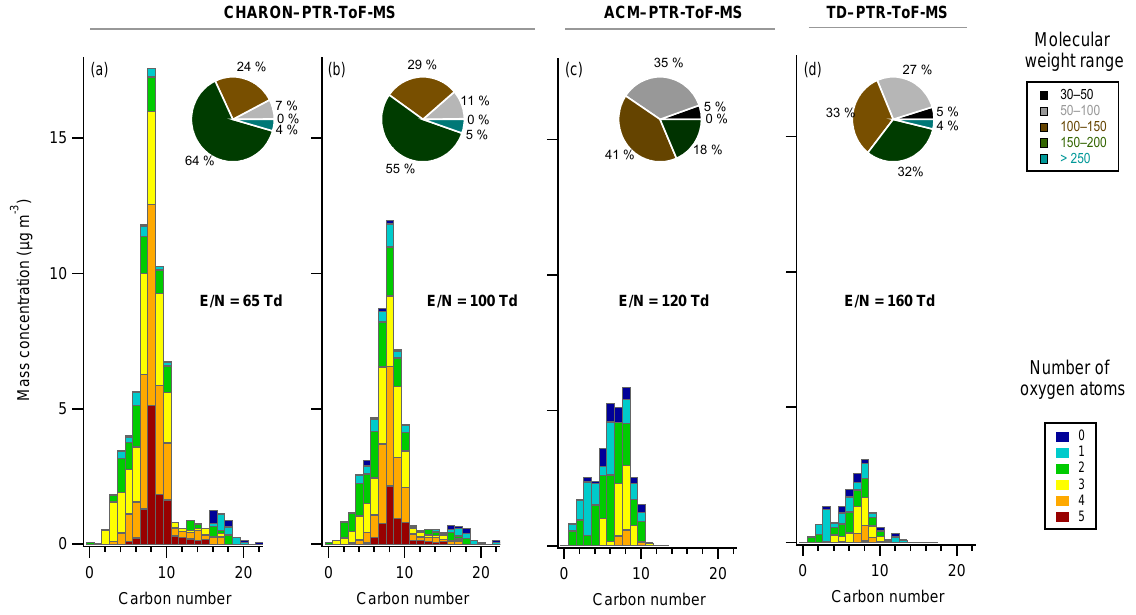
Figure 3. OA mass concentration ( y axis) distributed based on the number of carbon atoms ( x axis). Bar colours correspond to the contribu- tion of oxygen atoms starting from 0 (blue) to 5 (red) for each carbon group when (a) CHARON was operated at E/N = 65Td, (b) CHARON operated at 100Td, (c) ACM operated at 120Td and (d) TD operated at 160Td. Pie charts correspond to the molecular weight contribution to the overall mass starting from m/z 30–50 (black) up to m/z >250 (light blue). Results shown in this graph are from the tree emissions experiment at a high OA mass concentration, 25h after the ozone injection (Fig.